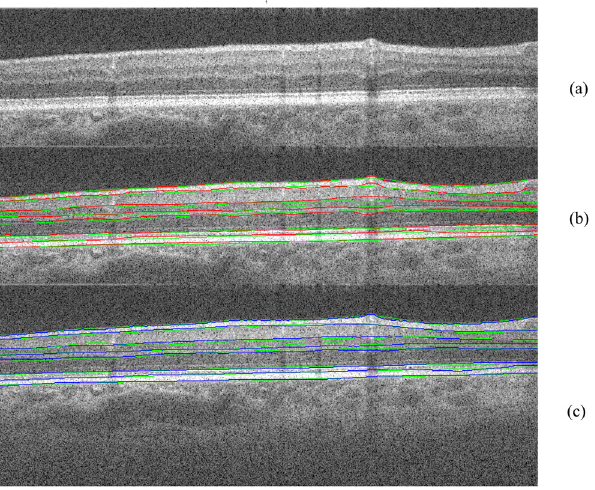
doi:10.1371/journal.pone.0133908.g010